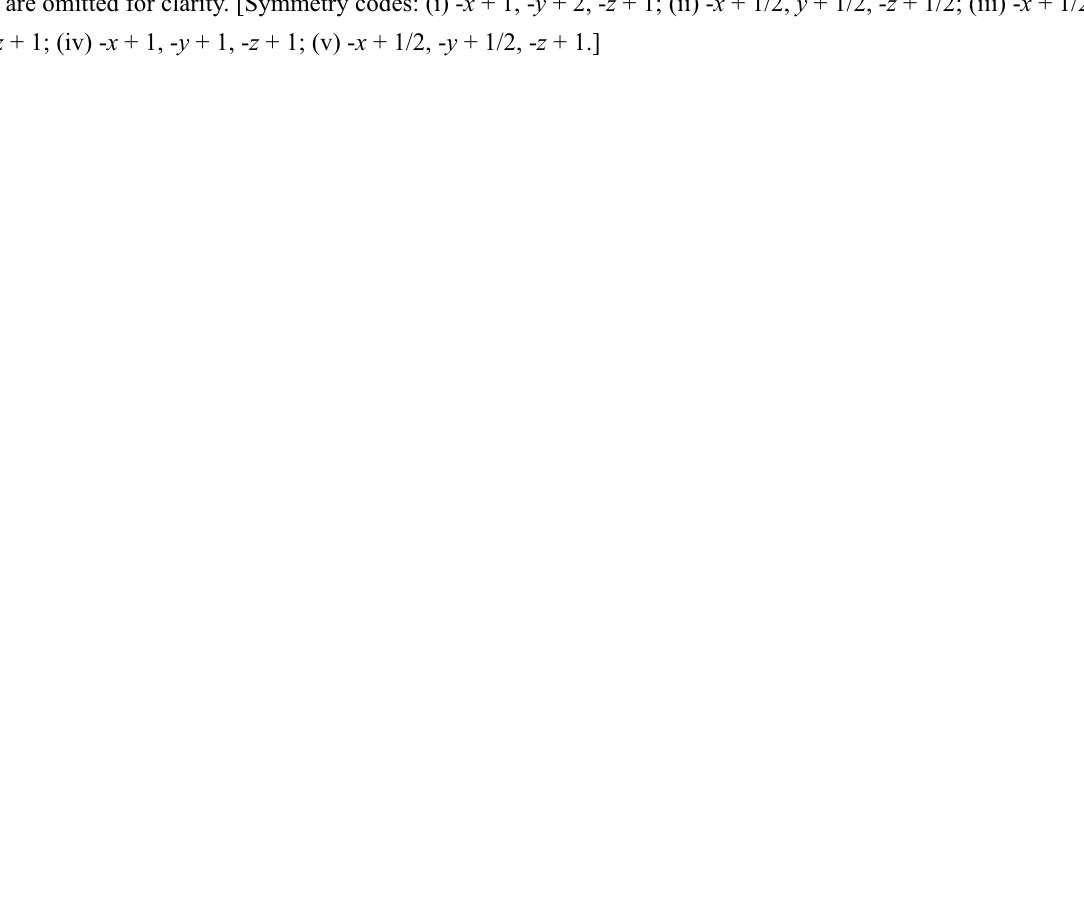
The ionic components of triethylene tetrammonium hexachloridorhodate(III) chloride with their hydrogen bond environment. Hydrogen atoms are drawn with an arbitrary radius and displacement ellipsoids are drawn at the 50% probability level. Dashed lines indicate further hydrogen bonds establishing a three dimensional network. Hydrogen atom labels are omitted for clarity. [Symmetry codes: (i) - x + 1, - y + 2, - z + 1; (ii) - x + 1/2, y + 1/2, - z + 1/2; (iii) - x + 1/2, y + 3/2, - z + 1; (iv) - x + 1, - y + 1, - z + 1; (v) - x + 1/2, - y + 1/2, - z +